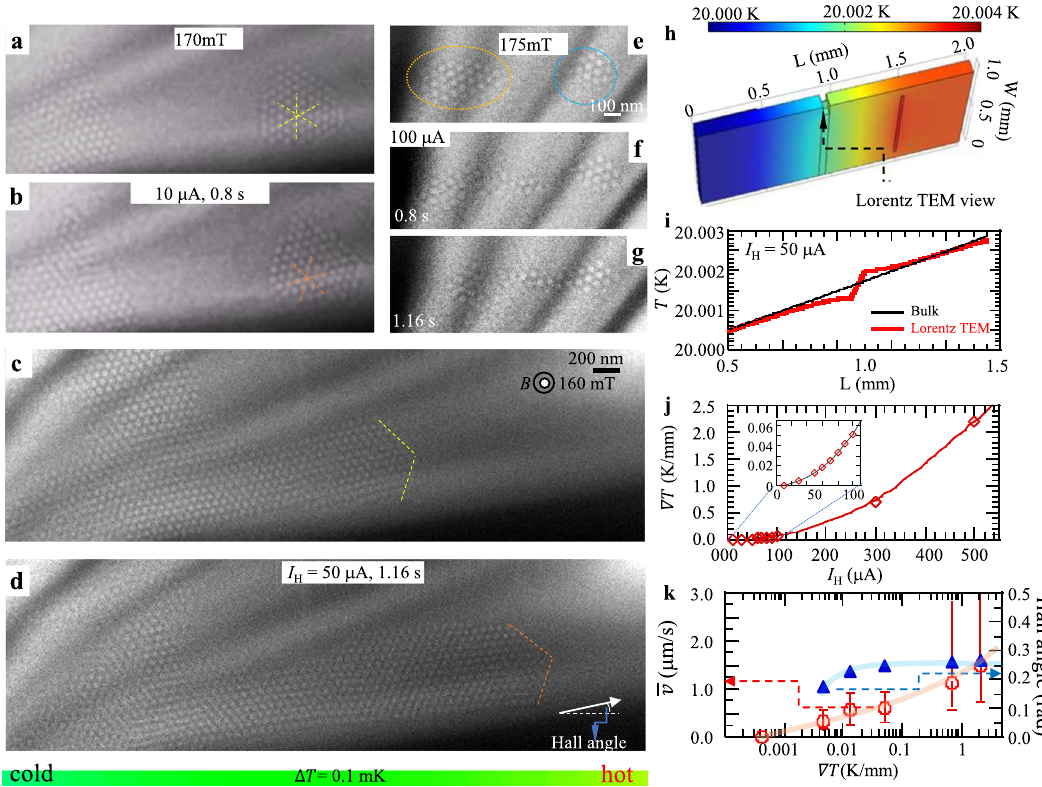
Fig. 3 Heat fl ow-driven skyrmion motion in a Cu 2 OSeO 3 thin plate. a , b Lorentz TEM images observed before ( a ) and during ( b) a 10 µ A current fl owing through the heater. c Skyrmion (white dot) domain coexistent with a vertical C domain (monotonic contrast) observed under a normal fi eld of 160 mT at 20 K in the (111) thin Cu 2 OSeO 3 . The boundaries between the skyrmion domain and C domain are signed by yellow dashed lines. d The domain boundaries between skyrmions and C domain drift from the lower left to the upper right (indicated by orange dashed lines) when a 50 µ A current fl ows through the heater (H) set on the right side of the device (Fig. 1c, d). e – g The left skyrmion island (encircled by a dotted yellow line) fl ows towards the right one (encircled by dotted blue line) with 100 µ A current fl ow. h T -map of the thin Cu 2 OSeO 3 during a 50 µ A current fl ow. Color bar indicates the T -scale. i Line pro fi les of ∇ T in the Lorentz TEM view area (the red line) and in the bulky Cu 2 OSeO 3 (thicker regions, the black line) at I H = 50 µ A. j Calculated ∇ T versus I ∇ T pro fi le at a range of I µ A. k Variation of the averaged velocity v ̅ (red H in the Lorentz TEM view area. The inset is an enlargement of the H from 0 to100 circles) of the domain wall (the boundary between skyrmion domain and C domain) and Hall angle (blue triangular) of the front skyrmion at the boundary with an increase of ∇ T , observed while holding a constant fi eld of 160 mT. The v ̅ is a ratio of the total drift distance to the duration (the duration is 1.36 s for the heater current I H = 0.3, 0.5 mA, while it is 1.68 s for I H = 0.3, 0.05, 0.1 mA) of skyrmion motions. The error bars represent the maximal and minimal averaged velocities deduced from the locally-averaged values approximately over the shorter time period of 0.2 – 0.6 s, as detailed in Supplementary Fig. 1. The pink and blue lines are eye guides for the changes of the velocity and Hall angle,